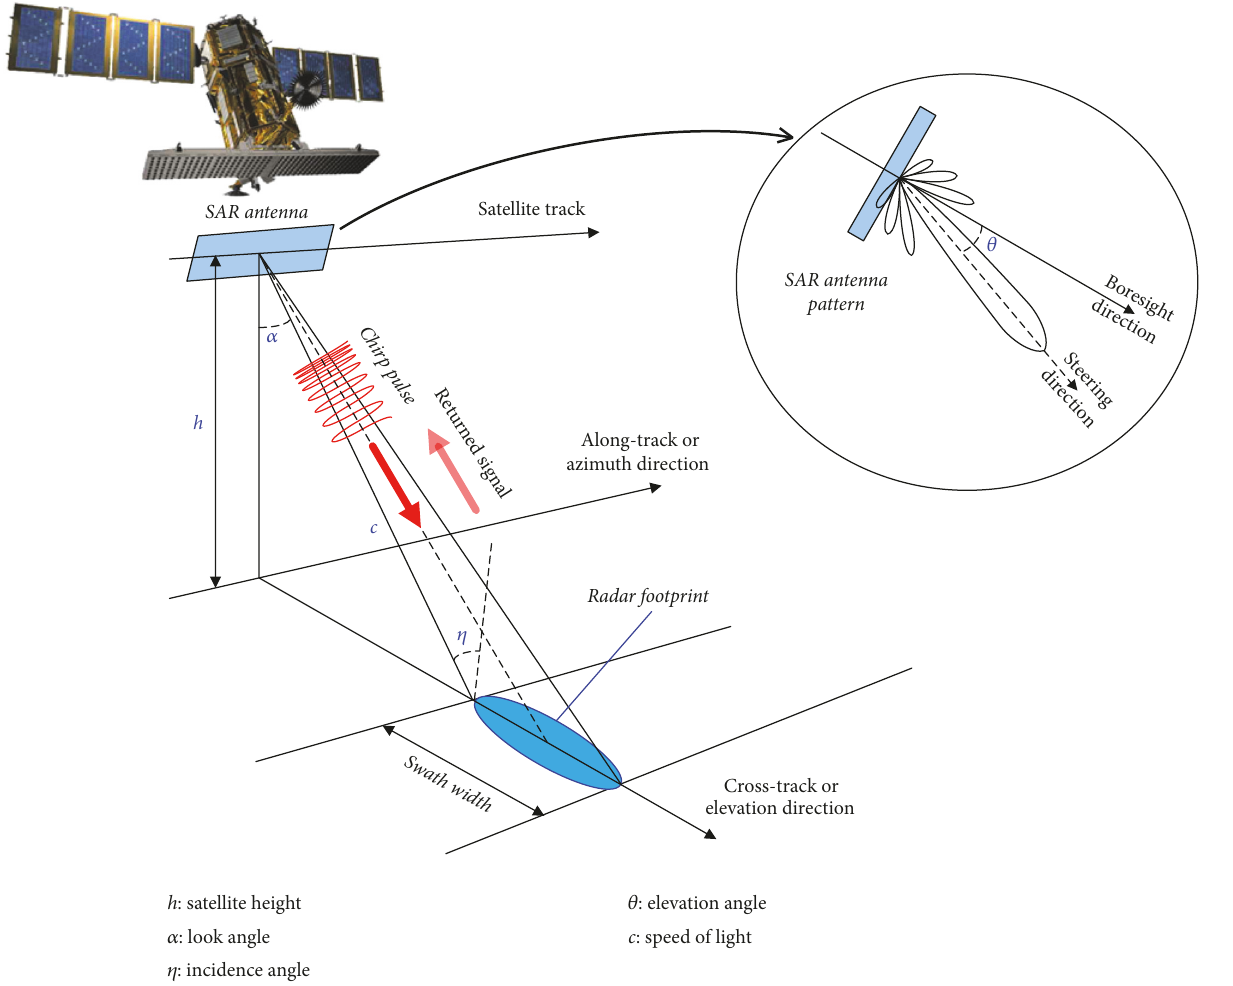
Figure 1: SAR satellite imaging